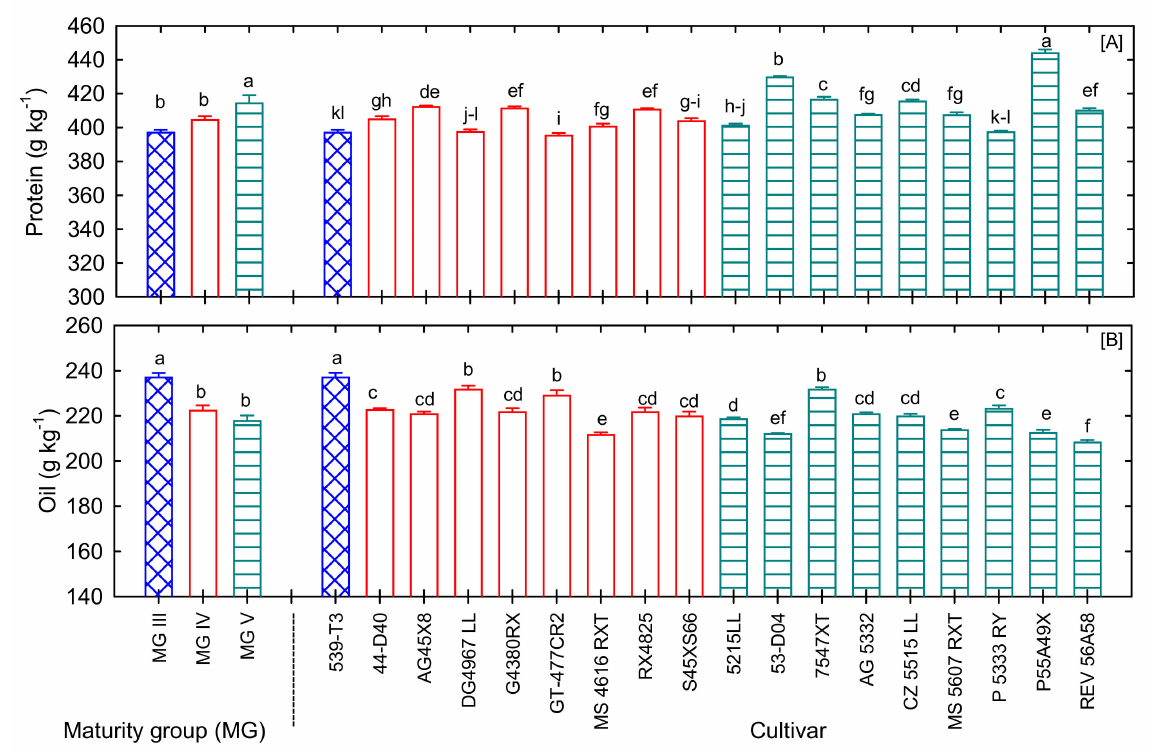
Figure 3. Variations in ( A ) protein and ( B ) oil composition of 18 soybean cultivars under well-watered and fertilized conditions. Bars denote mean ± SE ( n = 5). Bars with the same letter(s) indicate no significant difference among maturity groups (MG) or cultivars at p < 0.05